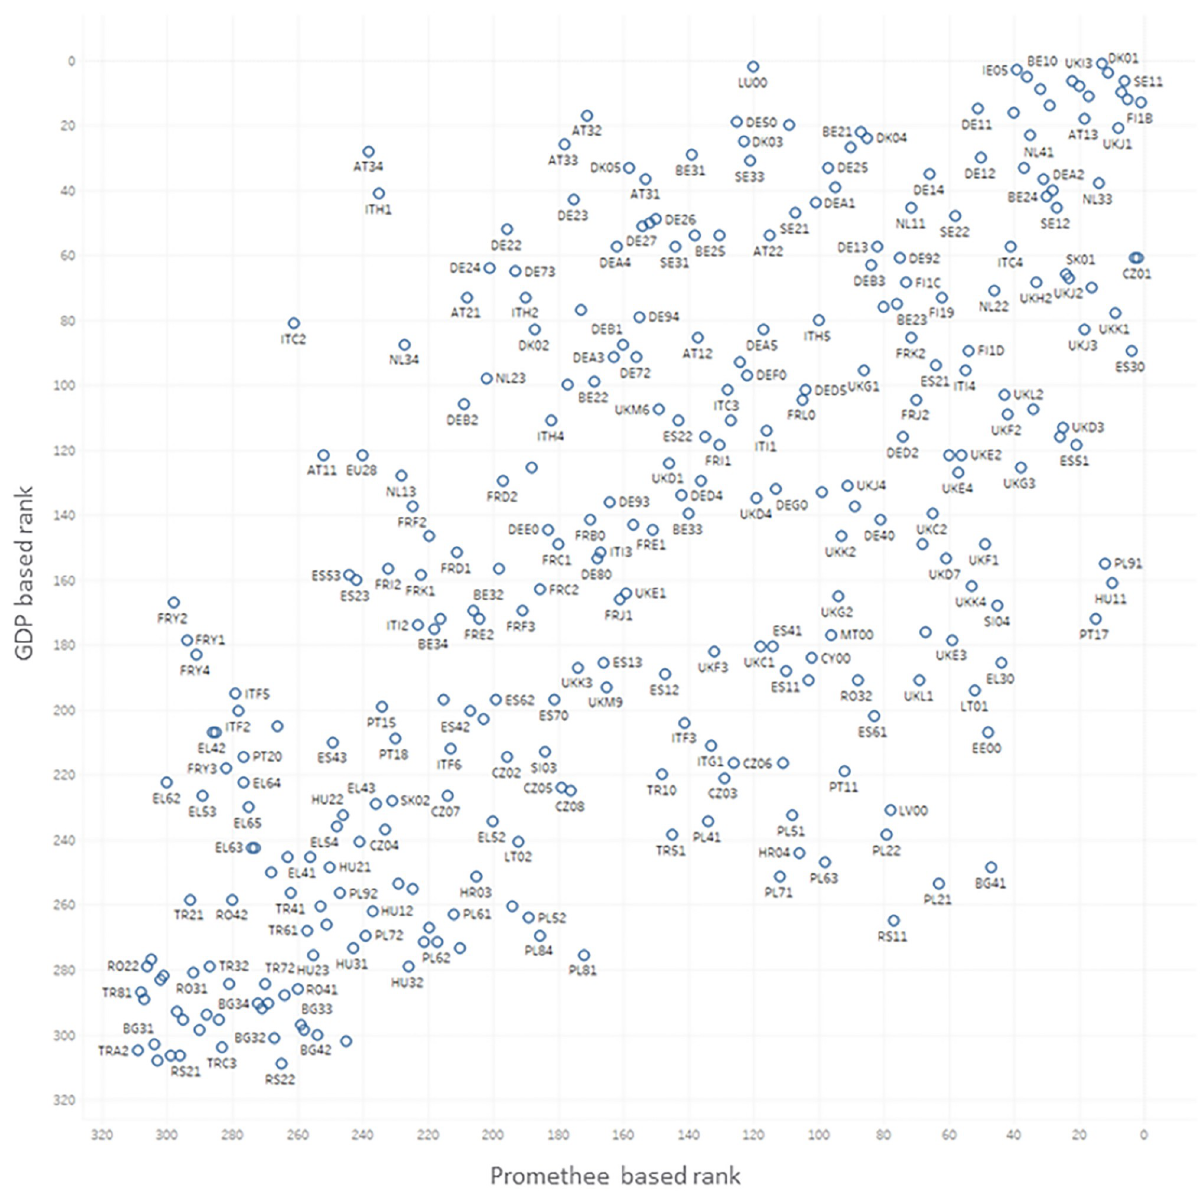
Fig 8. Correlation between GDP and our I4.0+ ranking system (r 2 =